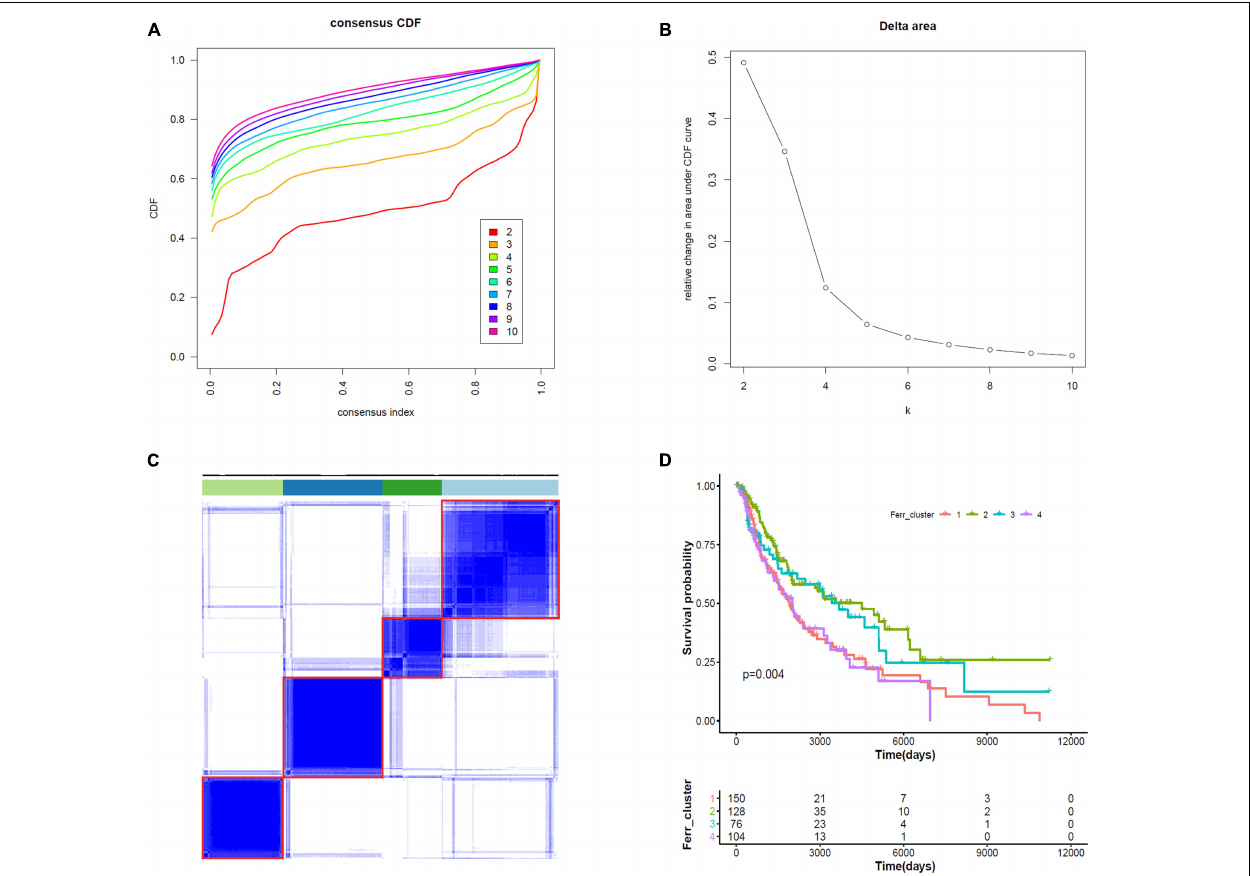
FIGURE 6 | Consensus clustering identifies four subtypes of cutaneous melanoma. (A) Consensus clustering cumulative distribution function (CDF) from k = 2 to k = 10. (B) Relative change in area under the CDF curve from k = 2 to k = 10. (C) Consensus clustering matrix for k = 4. (D) Kaplan–Meier curves for melanoma patients stratified by four